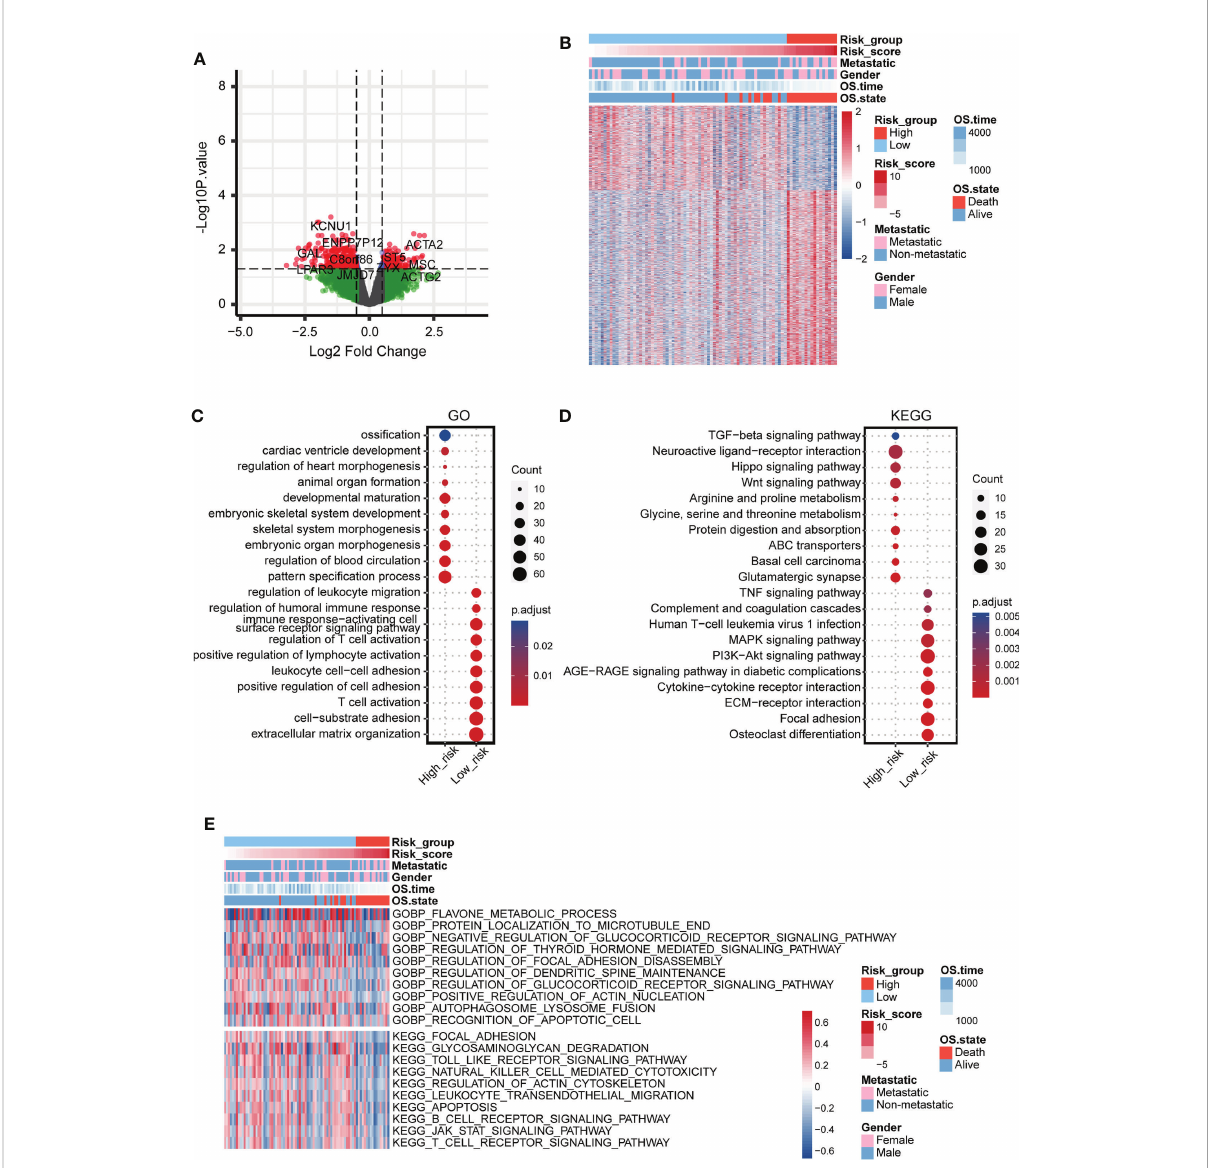
FIGURE 4 Functional annotation of the mitochondria-related signature. (A) Volcano plot for the DEGs between the two mitochondria-related signature score groups. (B) Heatmap for the DEGs between the two mitochondria-related signature score groups. (C) GO enrichment analysis for the DEGs between the two mitochondria-related signature score groups. (D) KEGG enrichment analysis for the DEGs between the two mitochondria-related signature score groups. (E) GSVA for the DEGs between the two mitochondria-related signature score